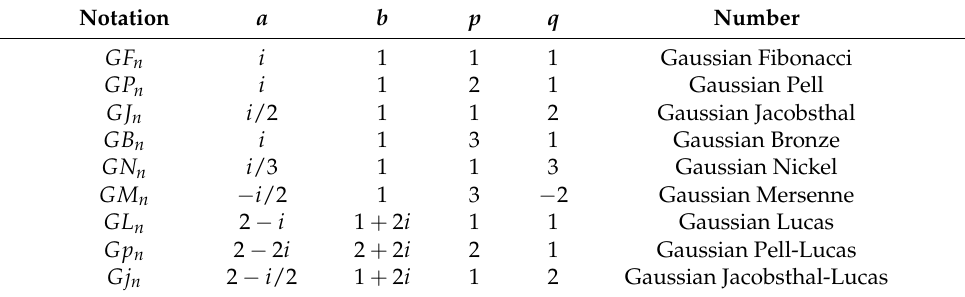
Table 2. Some kind of Gaussian type